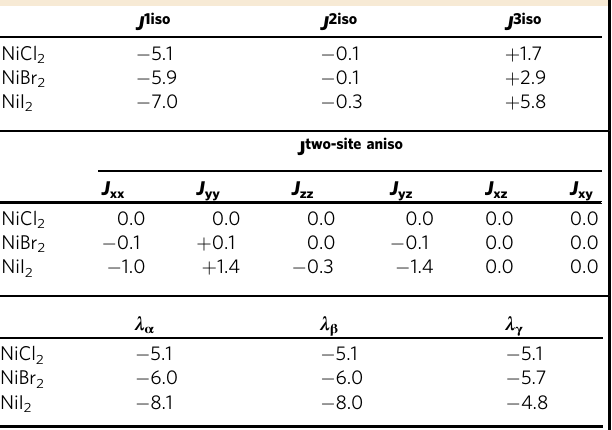
(upper table) Isotropic fi rst ( J 1iso ), second ( J 2iso ), and third ( J 3iso ) nearest neighbor interactions. (middletable) Matrixelements, inthe cartesian{ x , y , z } reference, of the anisotropicsymmetric exchange ( J S ) or two-site anisotropy ( J two-site aniso ) between fi rst nearest-neighbor spins. Site indices (ij) are omitted. Values refer to the Ni 0 − Ni 1 pair, with the Ni – Ni bonding vector parallel to the cartesian axis x . (bottom table) Principal values (eigenvalues) of the full fi rst nearest- neighbors exchange tensor, that is J 1 = J 1iso I + J two-site aniso . Exchange parameters are expressed in term of energy unit